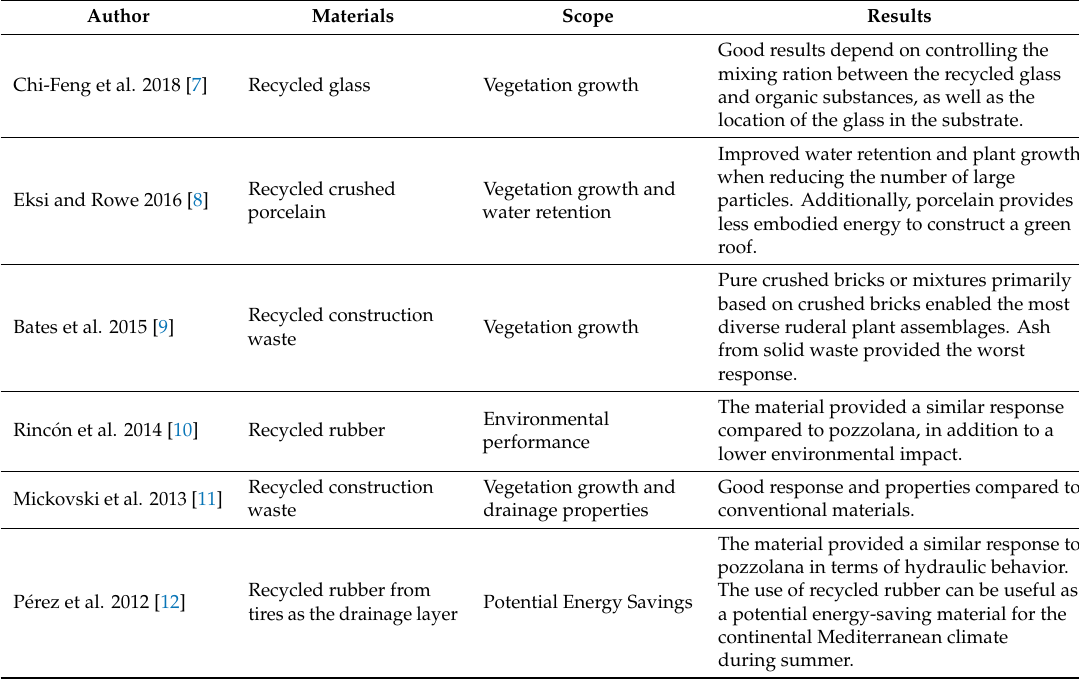
Table 1. Summary of works related to the use of recycled materials in green